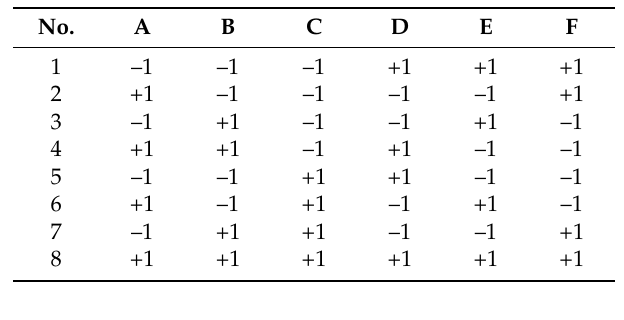
Table 4. Array of